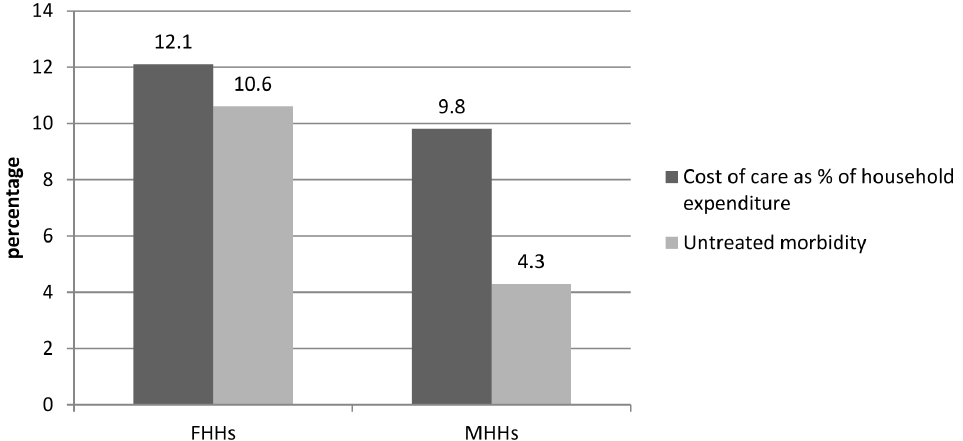
Figure 2. Cost burden and untreated morbidity ( p , 0.05 ). doi:10.1371/journal.pone.0093887.g002 PLOS ONE |